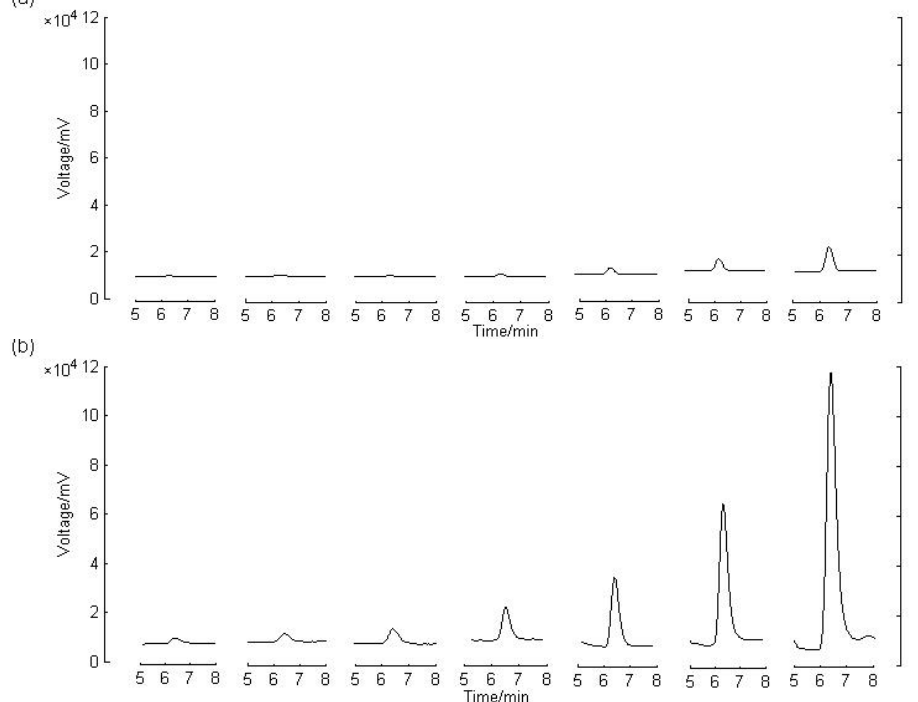
Figure 3. Chromatograms of clebuterol in urine samples of calibration curve. ( a ) The raw chromatograms of clenbuterol. ( b ) The chromatograms of clenbuterol obtained by ASSR with b = 0.0574. From left to right, the concentrations of clenbuterol are 0.2, 0.5, 1.0, 2.0, 5.0, 10.0 and 20.0 ng/mL,